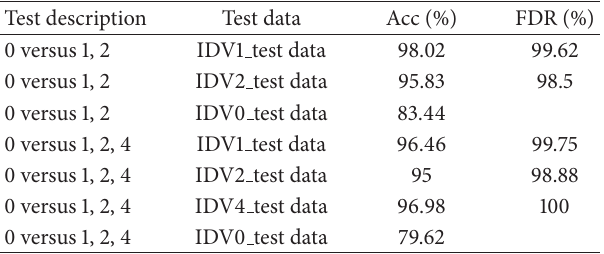
Table 5: Results of faults detection with one against all